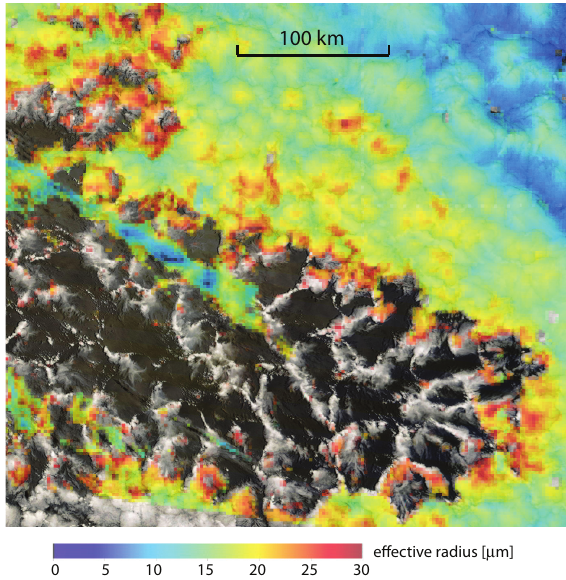
Fig. 14. MODIS-estimated cloud top effective radius r e (colors) from the 2.1µm near-IR channel, overlaid on MODIS 250m visible imagery which is revealed where r e retrievals are not performed because 1km pixels used for the retrieval are determined to be partially filled, too optically thin, or are cloud edge pixels.